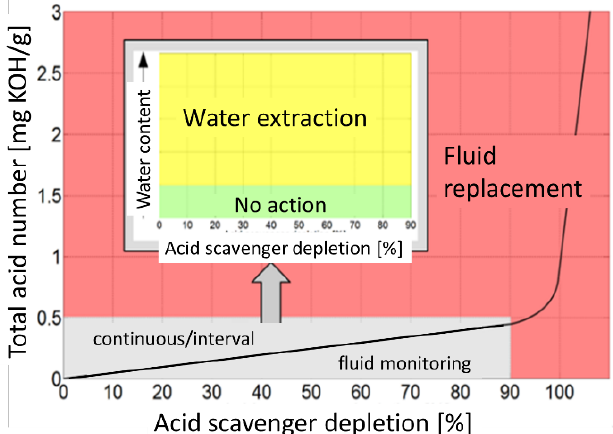
Figure 3. Development of acidity inside aviation hydraulic fluids as a function of acid scavenger depletion [11].